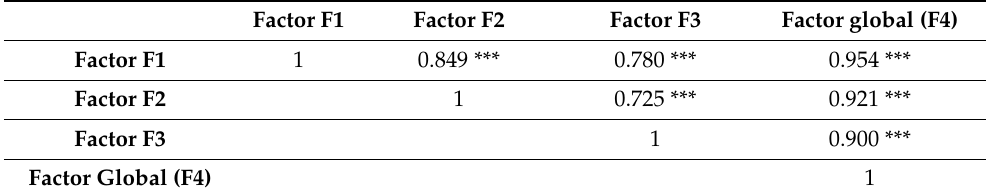
Table 9. Pierson’s correlation matrix between the scale